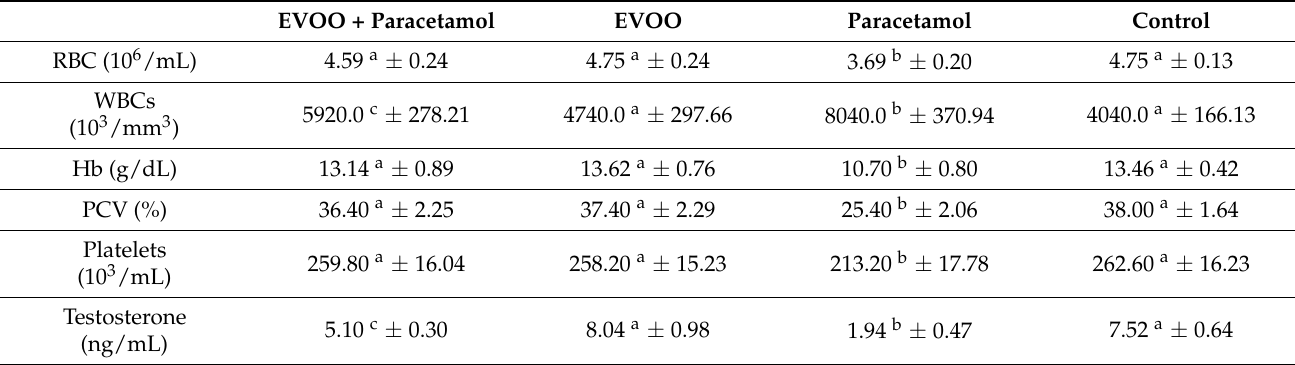
Table 5. Protective effect of EVOO against paracetamol toxicity in blood and testis in male Wistar rats.